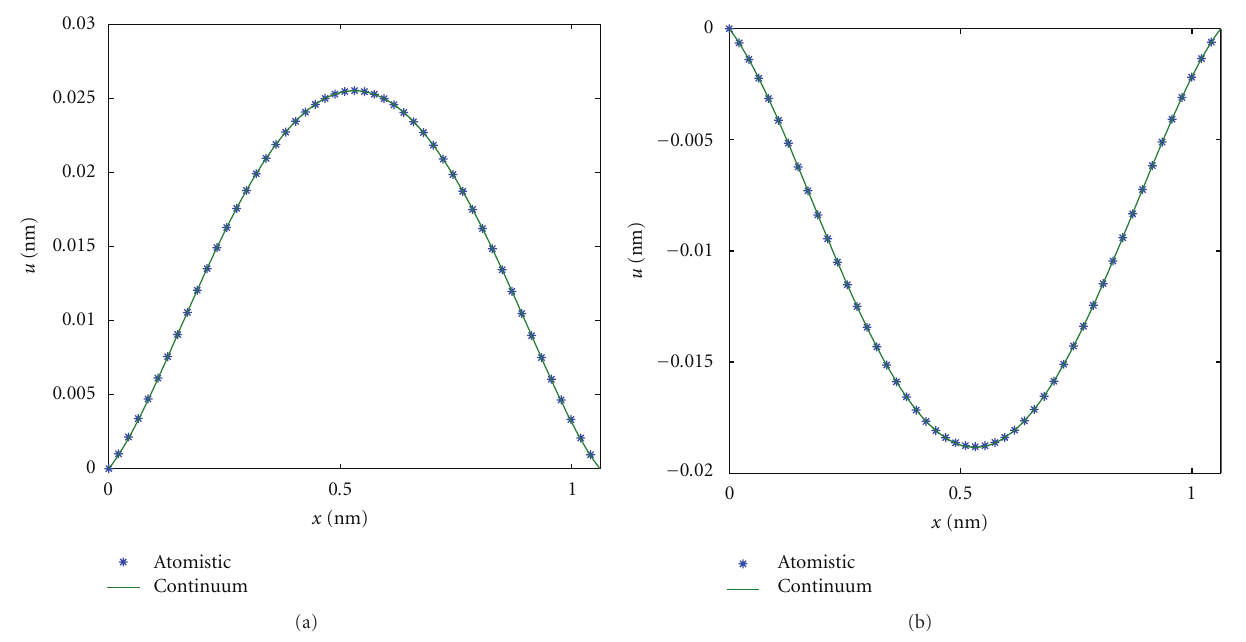
Figure 8: Results for an optimization with α = . 26nN nm, l = 1 . 7nm, and T = 0nN/nm. In (a), d = 0 . 31 nm. In (b), d = 0 . 37 nm. Note that the atoms on the edges of the layer, whose positions are prescribed, are not plotted because the continuum model does not describe the deflection of these